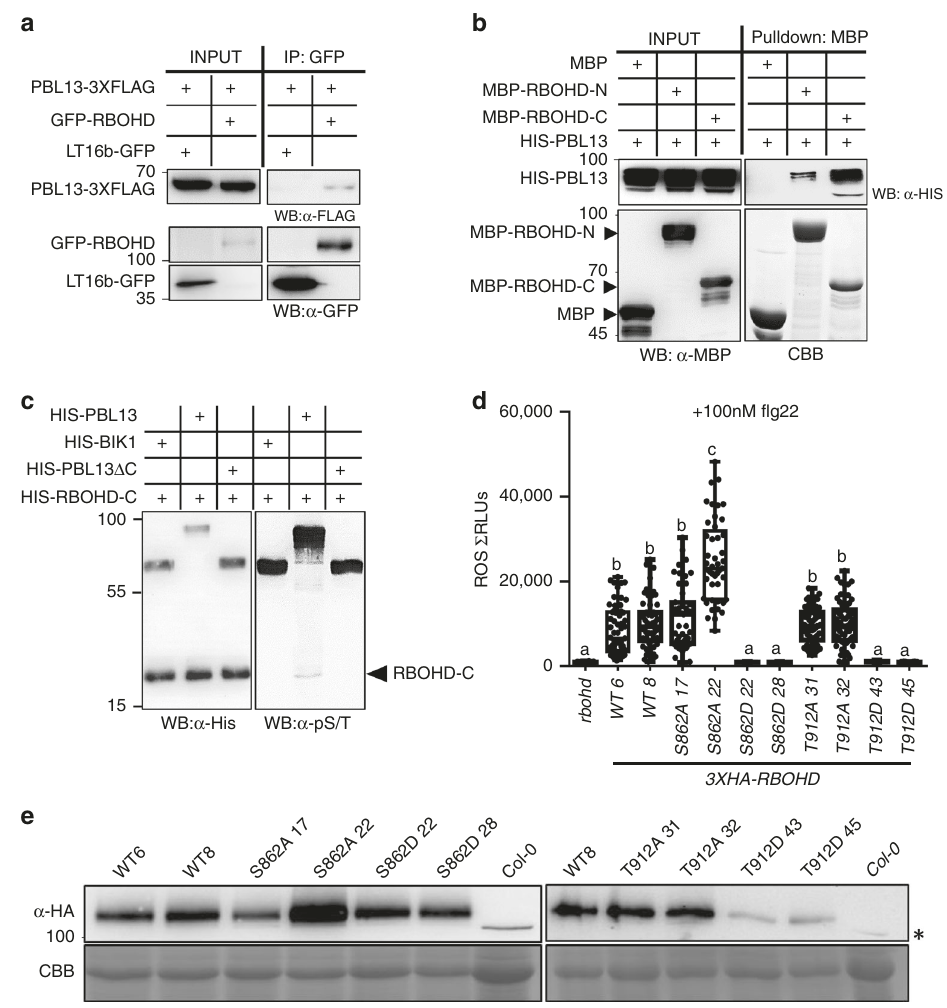
Fig. 1 PBL13 associates with and phosphorylates the C-terminus of RBOHD. a PBL13 interacts with RBOHD, but not the membrane-localized control LTI6B. PBL13-3xFLAG was co-expressed with GFP-RBOHD or LTI6b-GFP in Arabidopsis protoplasts and subjected to co-immunoprecipitation using anti- GFP antibodies. b PBL13 preferentially associates with the C-terminus of RBOHD (RBOHD-C) in vitro. RBOHD-N or RBOHD-C were co-expressed with HIS- PBL13 in E. coli and pulled-down with MBP agarose followed by immunoblotting with anti-MBP antibodies. CBB coomassie brilliant blue stained gel. c PBL13 phosphorylates RBOHD-C. In vitro phosphorylation was detected by incubating recombinant HIS-RBOHD-C with HIS-PBL13, HIS-BIK1 or HIS-PBL13 Δ C followed by immunoblotting with anti-phospho S/T antibody. d Phosophomimetic RBOHD S862D and RBOHD T912D abolish fl g22-mediated ROS production. The rbohd knockout was complemented with wild type, phosphonull or phosphomimetic mutants of 3xHA-RBOHD . Transgenic lines were treated with 100 nM fl g22 and the ROS burst was measured using a luminometer. For the box-plot, whiskers indicate minimum and maximum values, n > 40, line indicates the median, the box boundaries indicate the upper (25th percentile) and lower (75th percentile) quartiles. Statistical differences were determined by ANOVA with post-hoc Tukey HSD test, α = 0.05, and letters indicate signi fi cant differences. e Detection of RBOHD expression by anti-HA immunoblotting in Arabidopsis transgenic lines shown in d . Astericks = nonspeci fi c band. Twenty micrograms of protein was loaded for complementation lines and 60 µ g loaded for